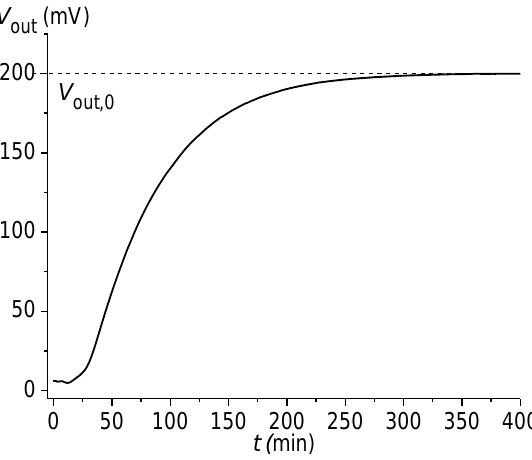
Figure B1. Sensor output voltage V during the gel swelling in PBS buffer (pH7.4, ionic out strength 0.15 M) when started from a dried state (an initial gel conditioning procedure).